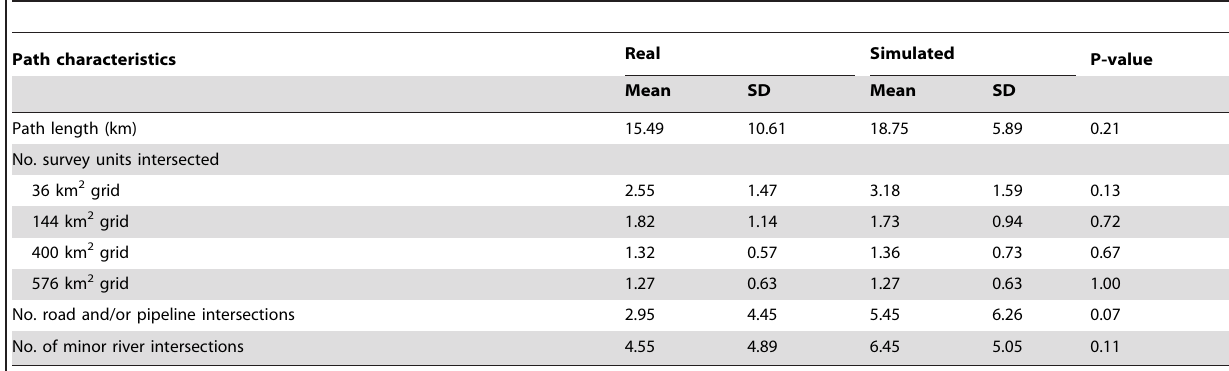
Table 2. Characteristics of 22 real and simulated 2-day wolf travel paths in northeastern Alberta, Canada, 2006–2008.